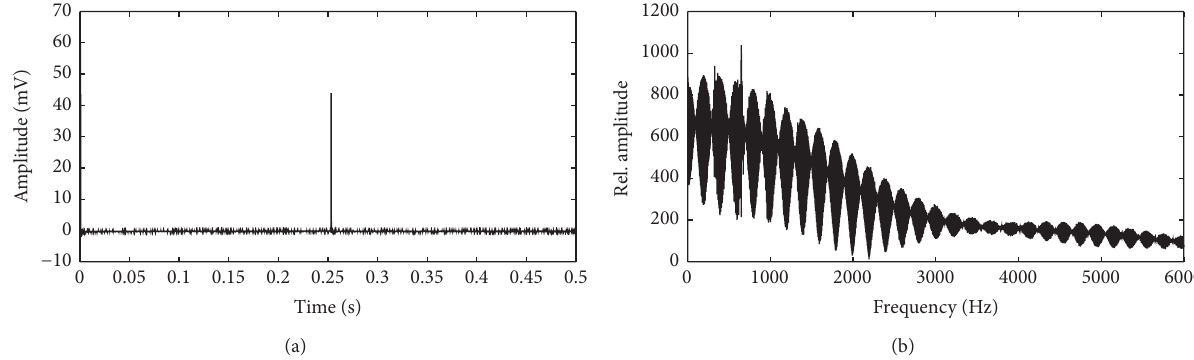
Figure 11: The disturbance pulse signal imposed by a hammer. (a) Time-domain signal, (b) frequency-domain signal.